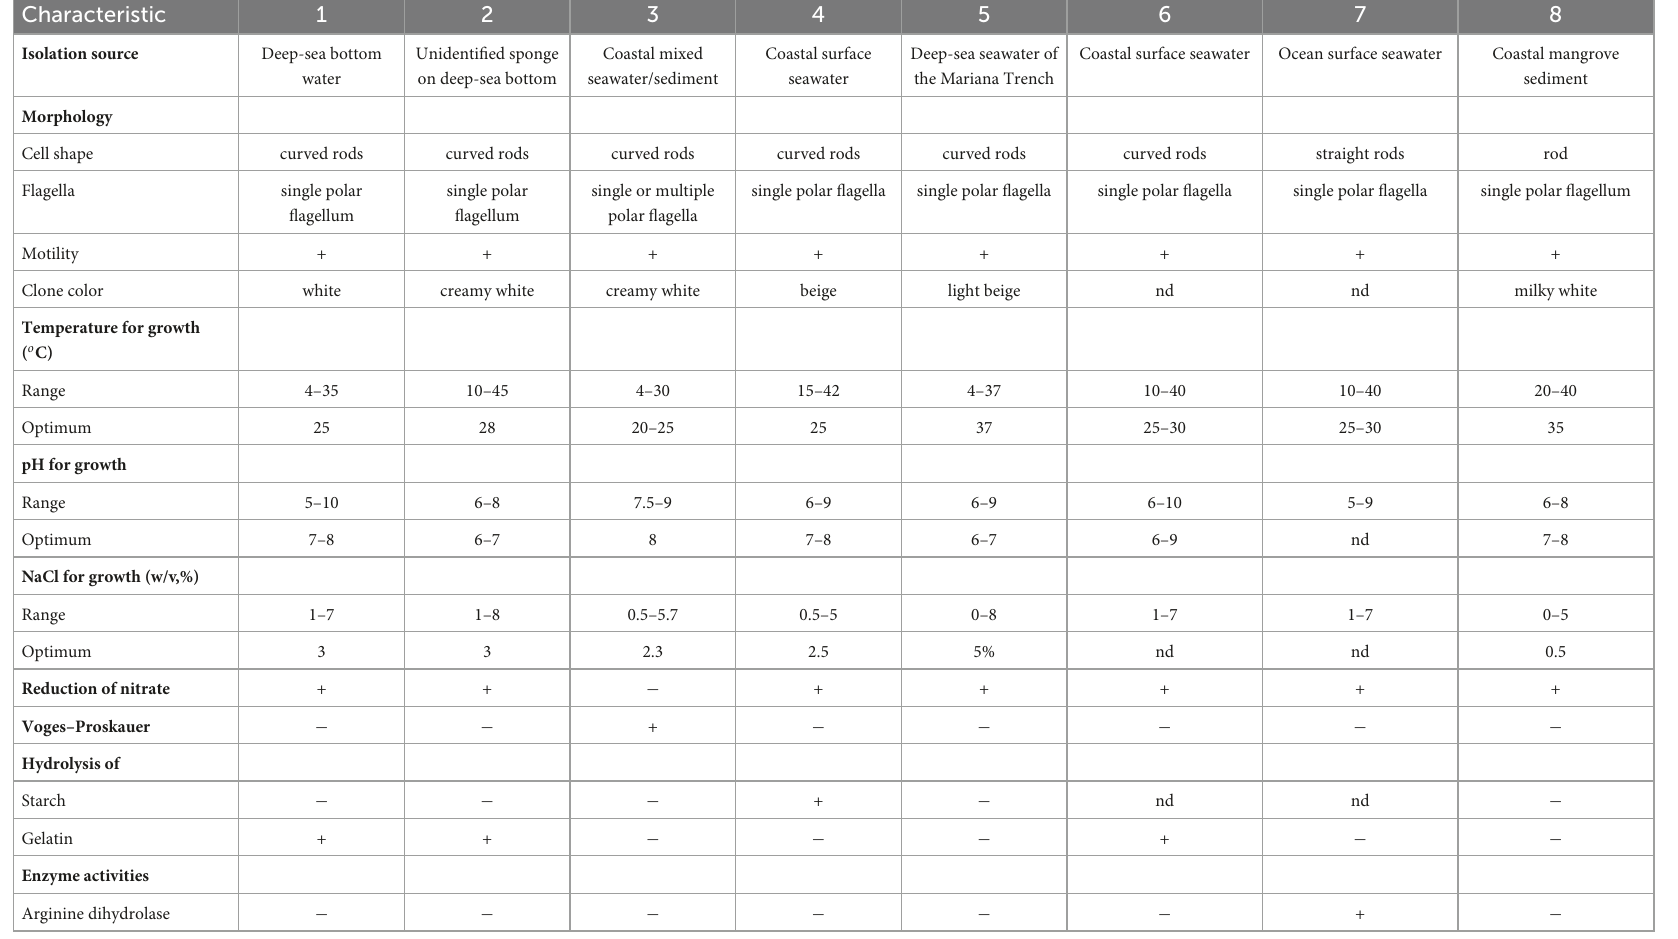
TABLE 2 Differentiating characteristics of the type strains of the type species within the Oceanobacter -related bacteria.